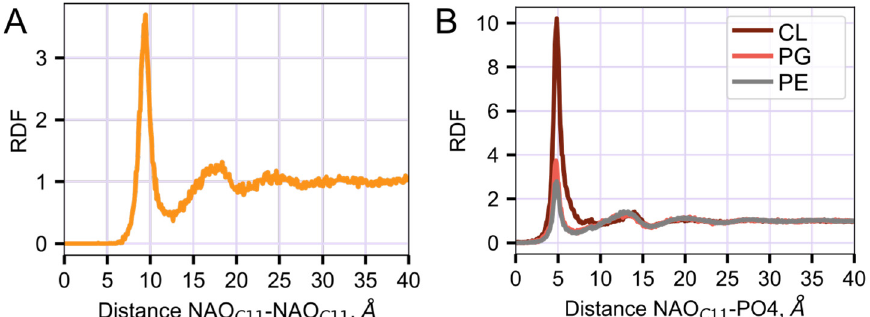
Figure 7. 2D RDFs of distances between the NAO C11-charged beads ( A ) and NAO C11-charged beads and phosphates of different lipids ( B ) calculated for the ratio 1:6 NAO:lipid.